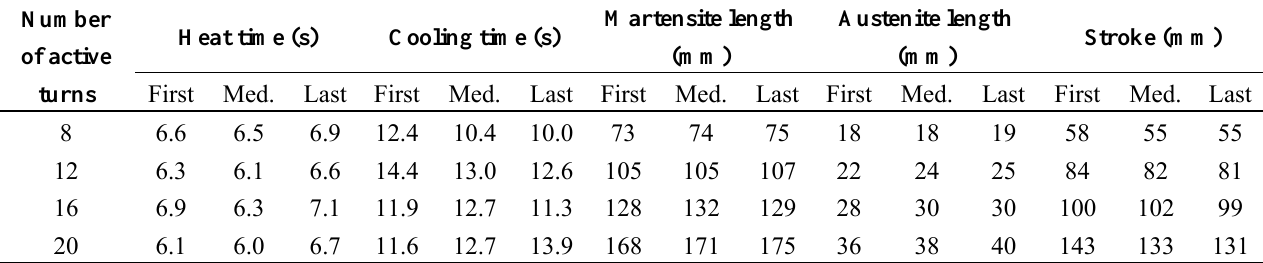
Table 7. The averaged first, median and last values for the number of active turns